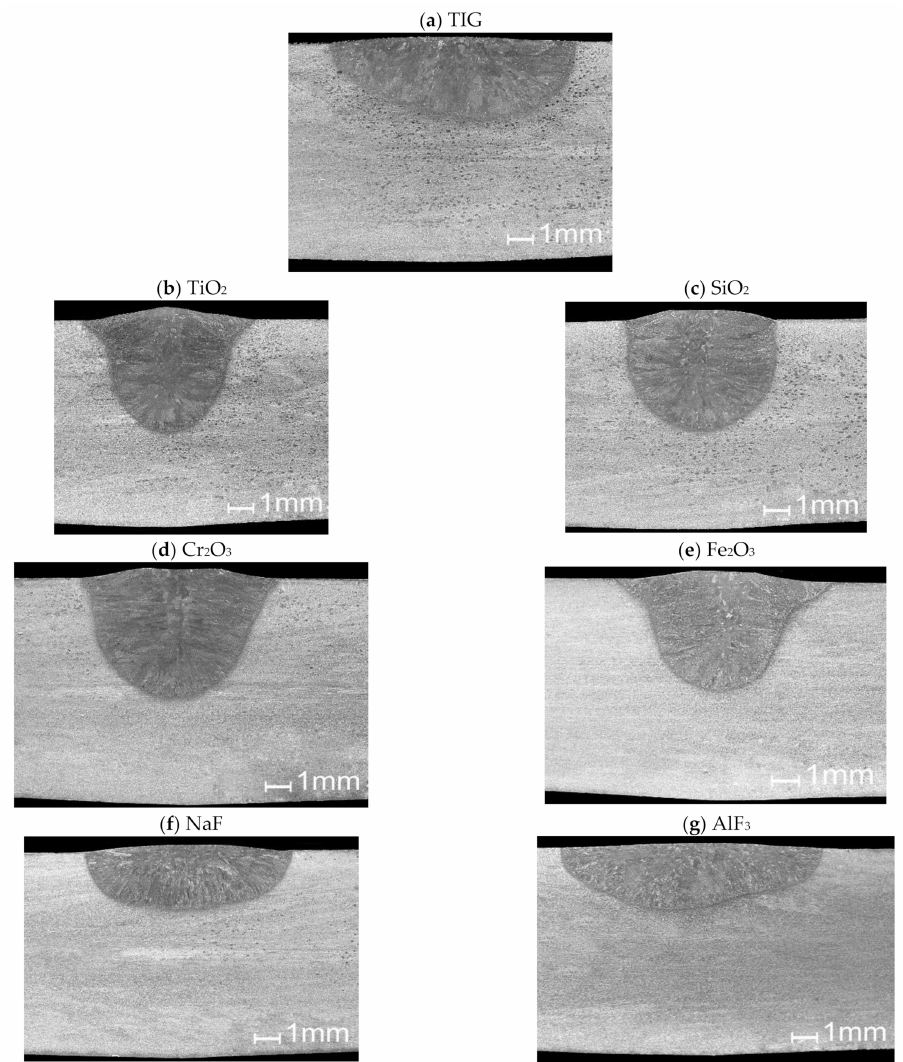
Figure 5. Macrostructure of the welds made on austenitic stainless steel AISI 304L using ( a ) conventional TIG without flux and A-TIG with various fluxes: ( b ) TiO 2 ( c ) SiO 2 ( d ) Cr 2 O 3 ( e ) Fe 2 O 3 ( f ) NaF ( g ) AlF 3